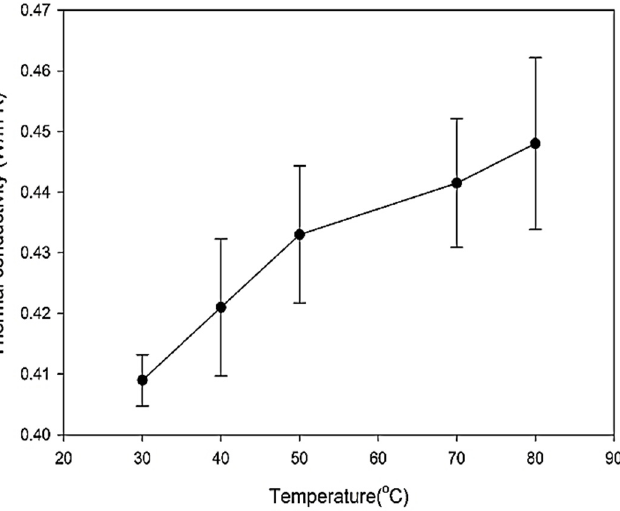
Figure 14. Graphical presentation of error difference of thermal conductivity of experimental and ASHRAE Standard data of base fluid.